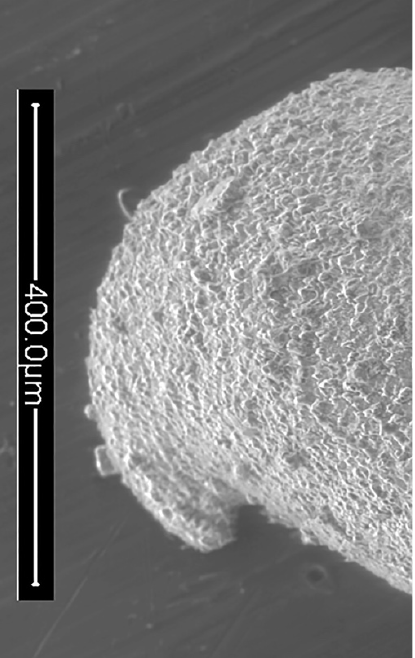
Figure 16. Acratia sp. D, left valve, close up of anterior of valve. IGM 5011(11). Scanning electron micrograph (secondary electrons). Scale bar = 400 microns.